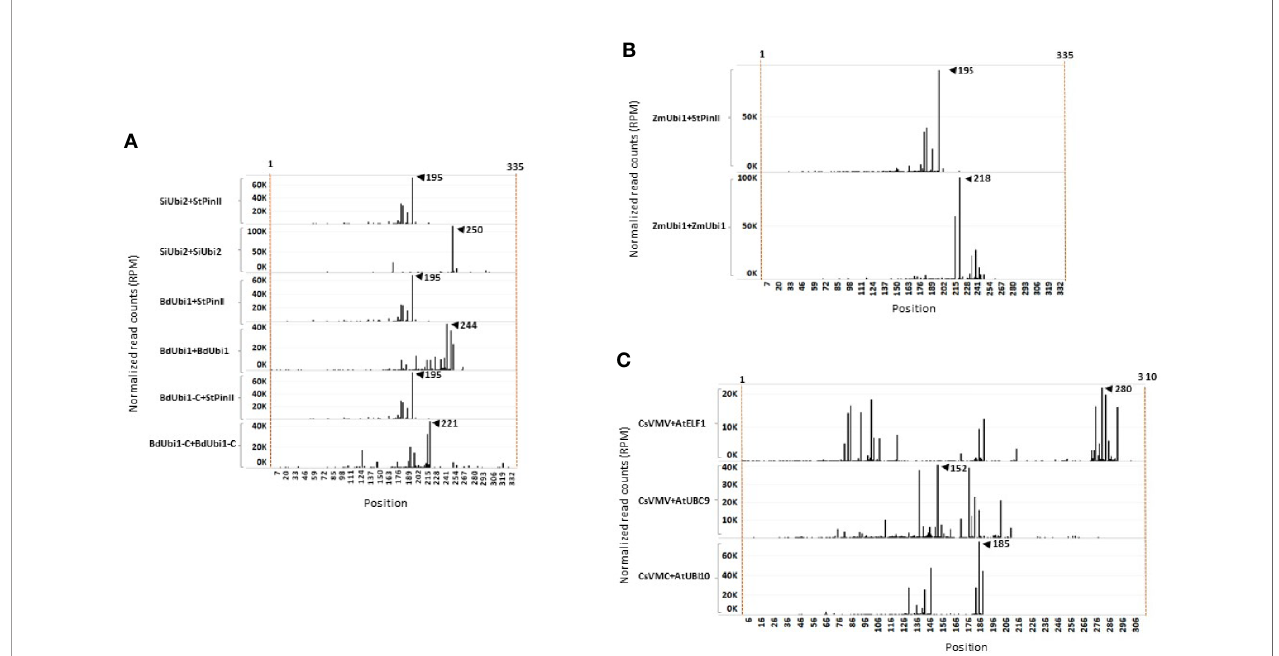
FIGURE 3 | 3 ′ RACE sequence mapping pro fi les of mRNA extracted from V6 maize leaves at the T 1 generation. Two independent events per construct were used for 3 ′ RACE analysis. mRNA poly(A) sites and its abundance re fl ected in individual peaks are shown for distinct TTs. On the X-axis, the position 1 starts at the last base of the reporter gene. The Y-axis indicates the normalized reads number per million (RPM) of the 3 ′ RACE deep sequencing read end (after trimming poly (A) mapping for each position). The peak of poly(A) site representing mRNA abundance is determined using a cut-off of 10,000 RPM. For each construct, two individual samples were sequenced, and similar results were observed. The representative data is shown here in the sequence mapping pro fi les of up to 335 nt. (A) Comparison of constructs containing the StPinII TT ( SiUbi2+PinII ; BdUbi1-C+PinII , BdUbi1+PinII ), SiUbi2 TT ( SiUbi2+SiUbi2 ), BdUbi1 TT ( BdUbi1+BdUbi1 ) and BdUbi1-C TT ( BdUbi1-C+BdUbi1-C ). (B) Comparison of StPinII TT ( ZmUbi1+StPinII ) and ZmUbi1 TT ( ZmUbi1+ZmUbi1 ). (C) Comparison of AtELF1 TT (CsVMV + AtELF1 ), AtUBC9 TT (CsVMV+ AtUBC9 ) and AtUbi10 TT ( ZmUbi1+AtUbi10 ). The number indicated by the black triangle represents the position of the highest peak (highest mRNA abundance) for that